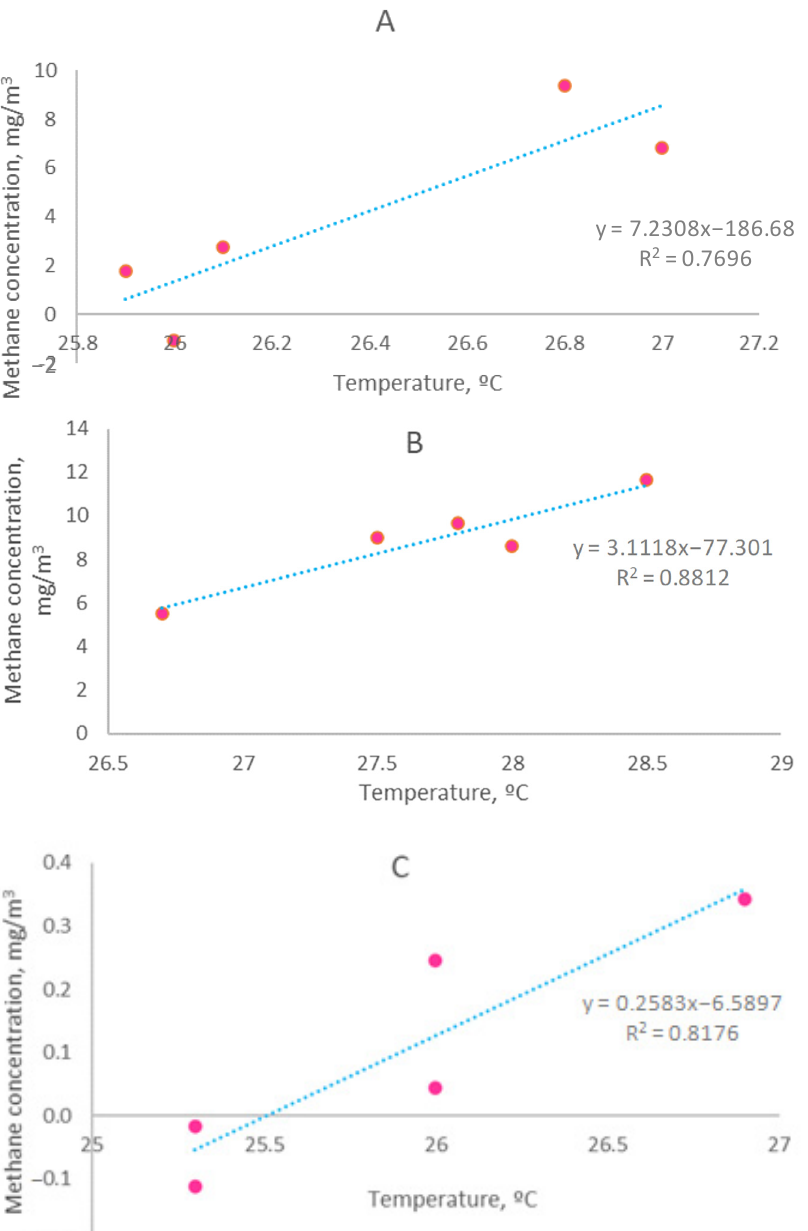
at Kailaankuppam during all three major stages of cultivation: ( A ) vegetative, ( B ) reproductive, and ( C )